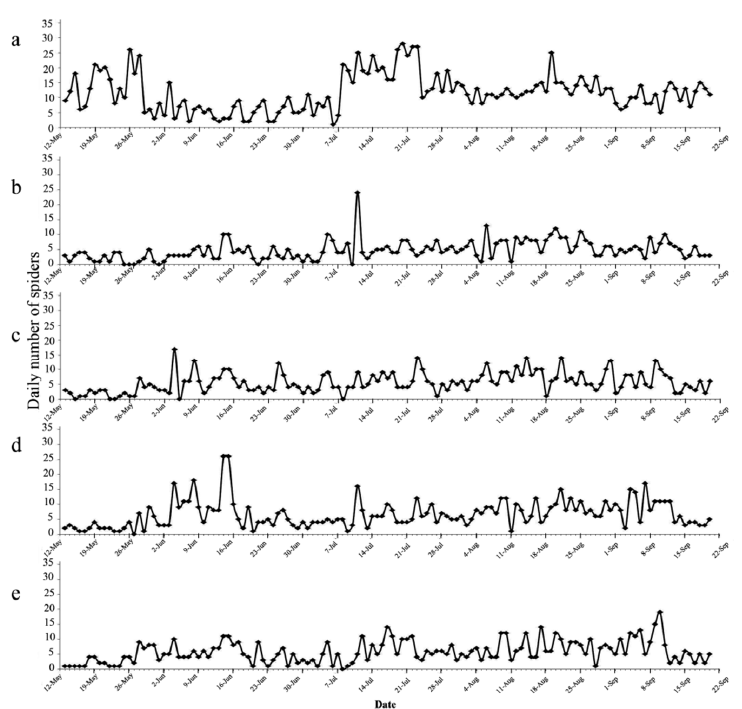
Figure 6. Numbers of spiders trapped/collected in the five treatments during the course of field experiment (13 May to 20 September 2015). ( a ) suction machine; ( b ) yellow sticky trap; ( c ) white light trap; ( d ) green light trap; ( e ) yellow light trap.